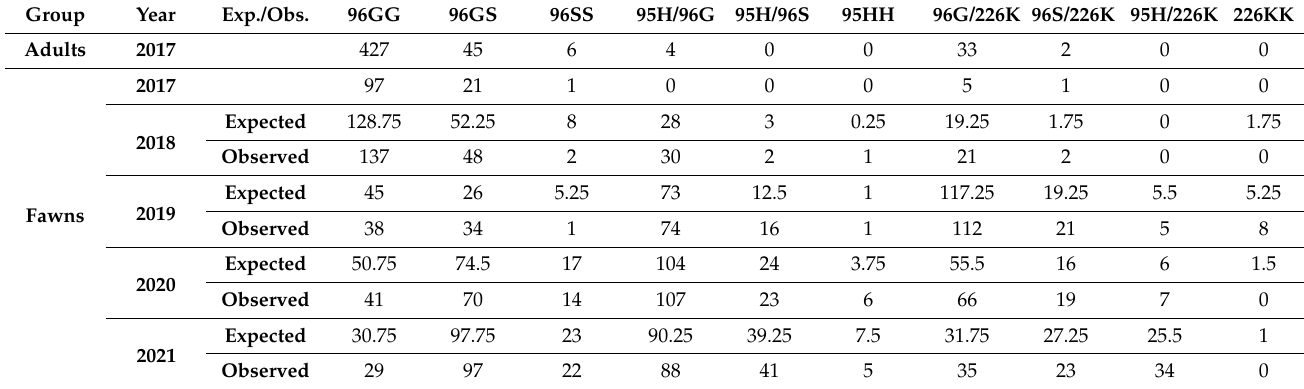
Figure 3. Changes in PRNP genotype frequencies among breeding animals and fawns, both prior to and following selective breeding intervention. The frequency of 96GG genotypes shifted markedly from a high of over 80% to less than 10% over the first phase of the project, with concurrent gains seen in 95H, 96S, and 226K carriers. Table 1. PRNP genotypes present in adult breeding animals and fawns throughout the course of the study. Data include genotypes present prior to selective breeding efforts (2017), as well as expected and observed numbers of fawns in the initial phase of the project. Expected and observed numbers were statistically similar (two-tailed chi-square test with Yate’s correction), indicating predictable patterns of Mendelian inheritance for the PRNP